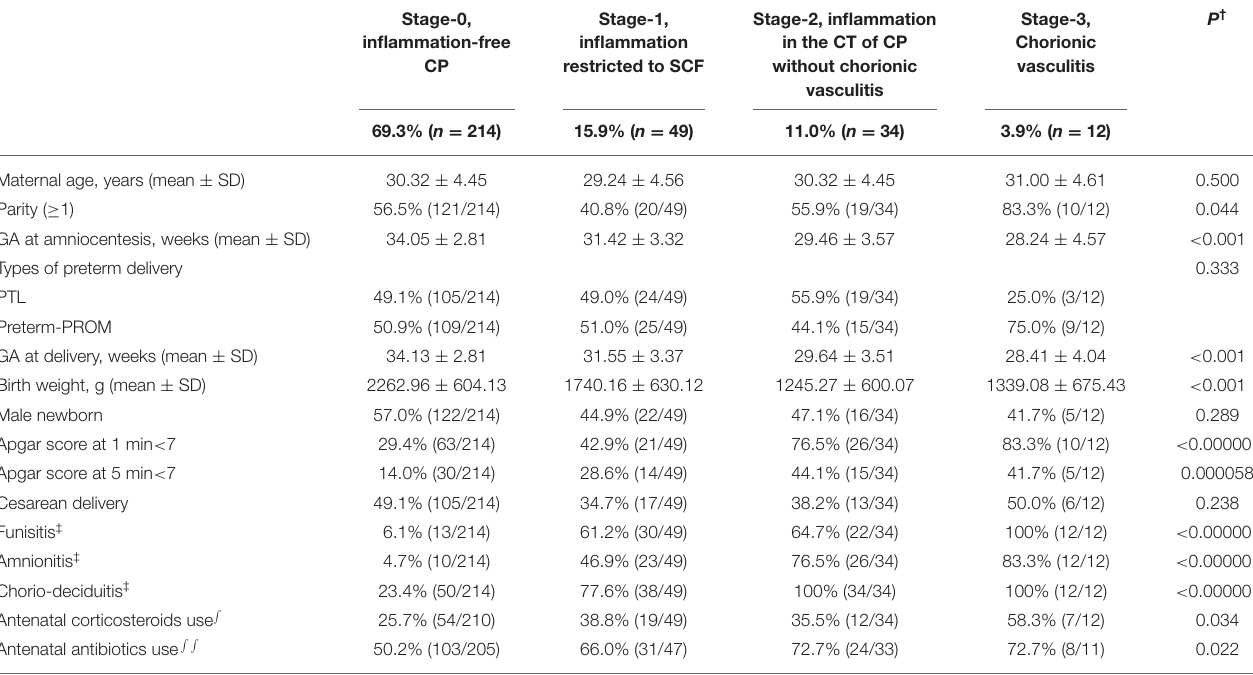
TABLE 1 | Clinical characteristics and pregnancy outcomes according to the progression of inflammation within the chorionic plate (CP). Stage-0,